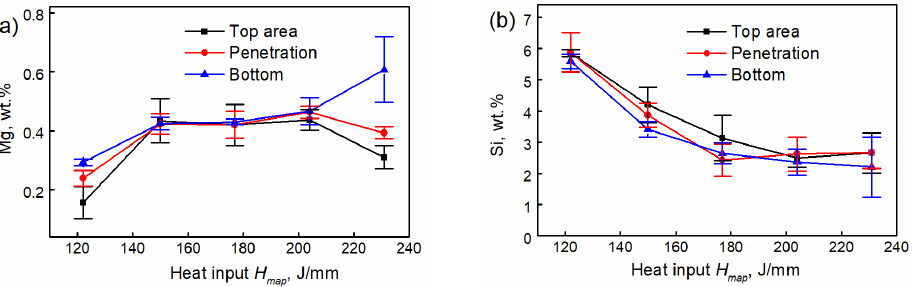
Figure 8. Concentration change in composition for ( a ) Mg and ( b ) Si with heat inputs for different zones.